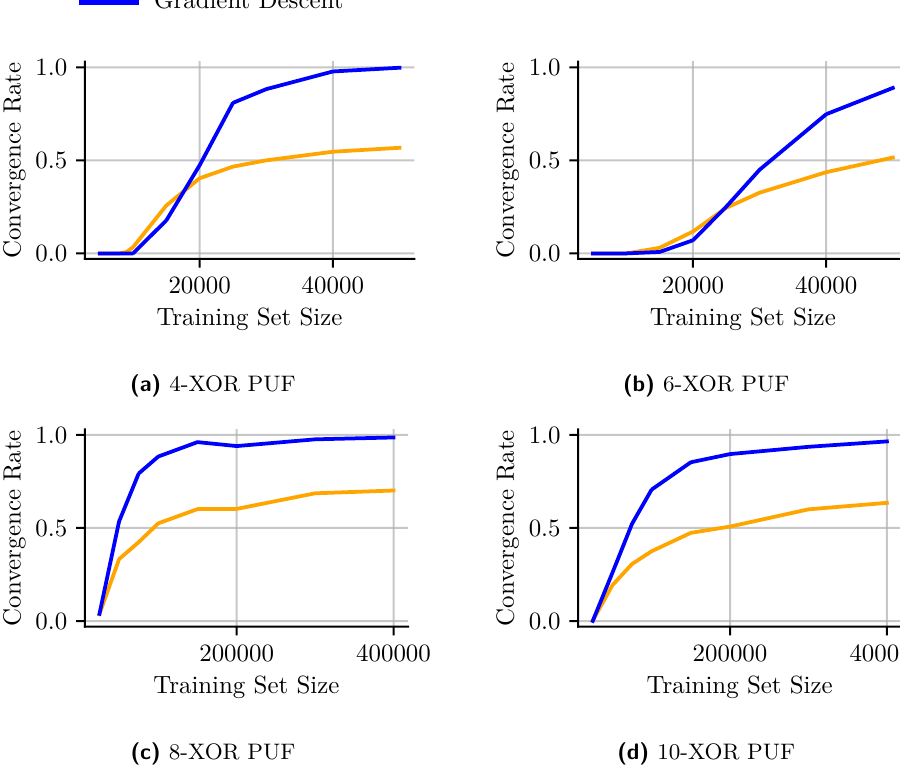
Figure 5: In this experiment, we compare the convergence rate between CMA-ES and (stochastic) gradient descent for the basic reliability attack, in which a single APUF candidate is found in each trial. A PUF population size of 50 was used. The error variance σ 2 was set to 0 . 1 and reliability information was collected over 10